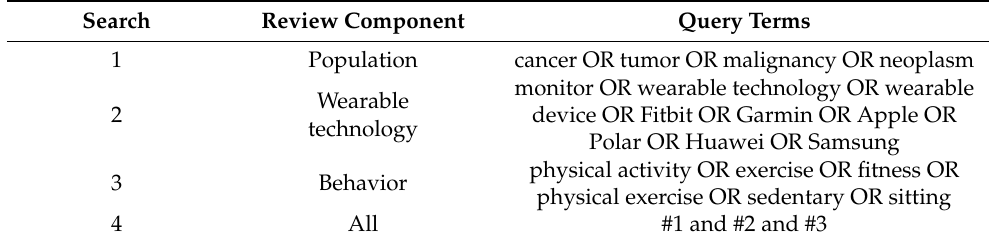
Table 1. Scoping review search strategy.